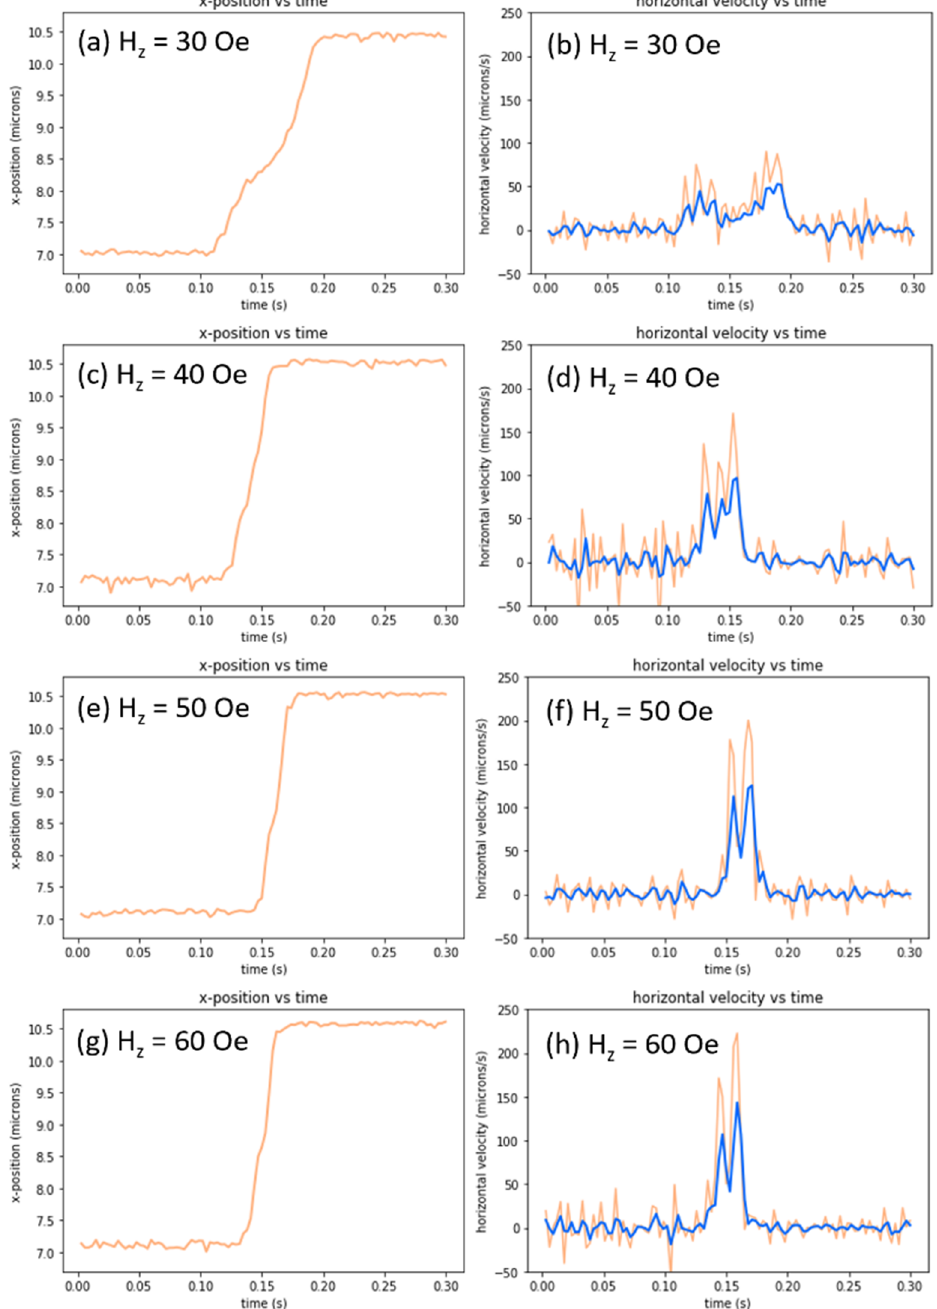
Figure 3. Short-range hopping position vs. time and velocity vs. time graphs for Dynabeads M-270 particles for switching out-of-plane fields H z of 30 Oe ( a , b ), 40 Oe ( c , d ), 50 Oe ( e , f ), and 60 Oe ( g , h ). Three-frame average velocities are shown in blue. For all graphs, the in-plane field H x = 35 Oe.